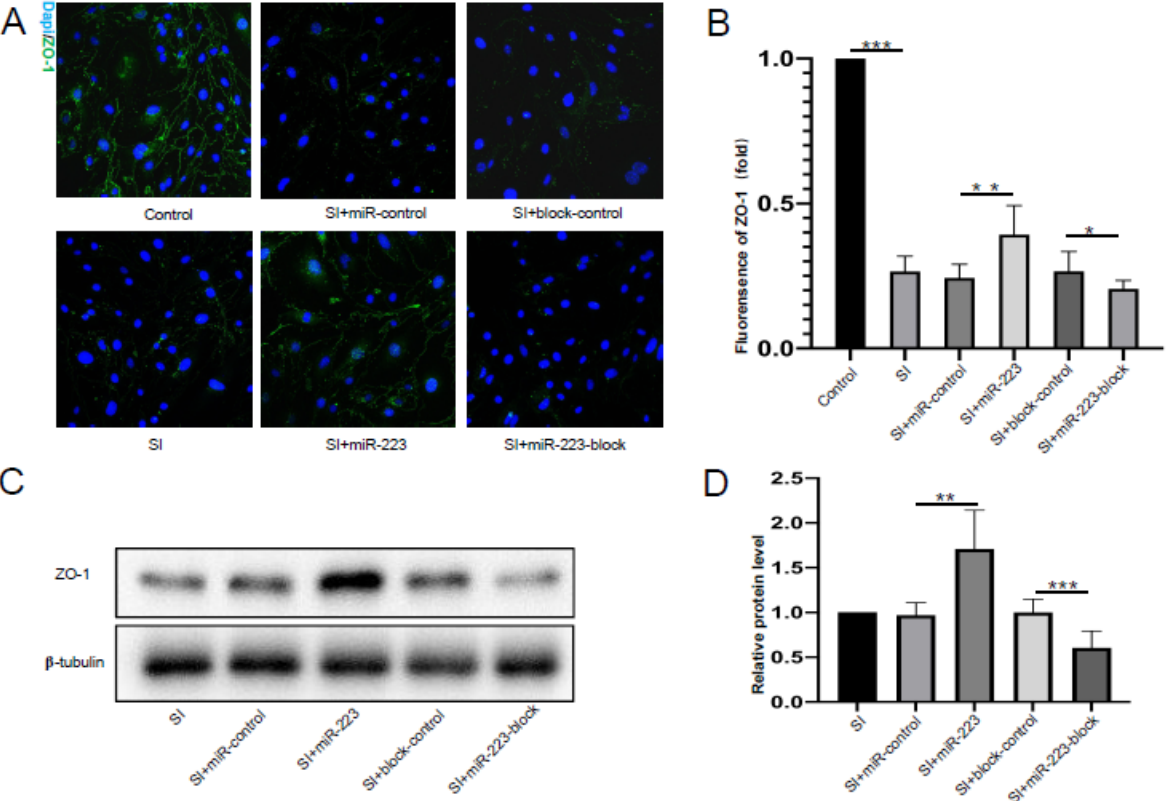
Figure 3. MiR-223 rescued the decrease in tight junction proteins in bEnd.3 cells after SI. ( A ) Im- munocytochemistry from fixed bEnd.3 cells 24 h after SI. Note that miR-223 overexpressed bEnd.3 cells have higher fluorescence intensity compared with control group. Scale bar = 30 mm. ( B ) Bar graphs showing the fluorescence of ZO-1. ( C ) Representative results of ZO-1 expression 24 h after stretch injury. ( D ) Bar graphs showing the quantification of ZO-1 expression. n = 6 per group; data are presented as the mean ± SD; * p < 0.05, ** p < 0.01, *** p < 0.001, SI versus Control group, miR-223 versus miR-control group, miR-223-block versus block-control group. miR-223: microRNA-223; h: hour; ZO-1: zonula occludens 1; SI: stretch injury.